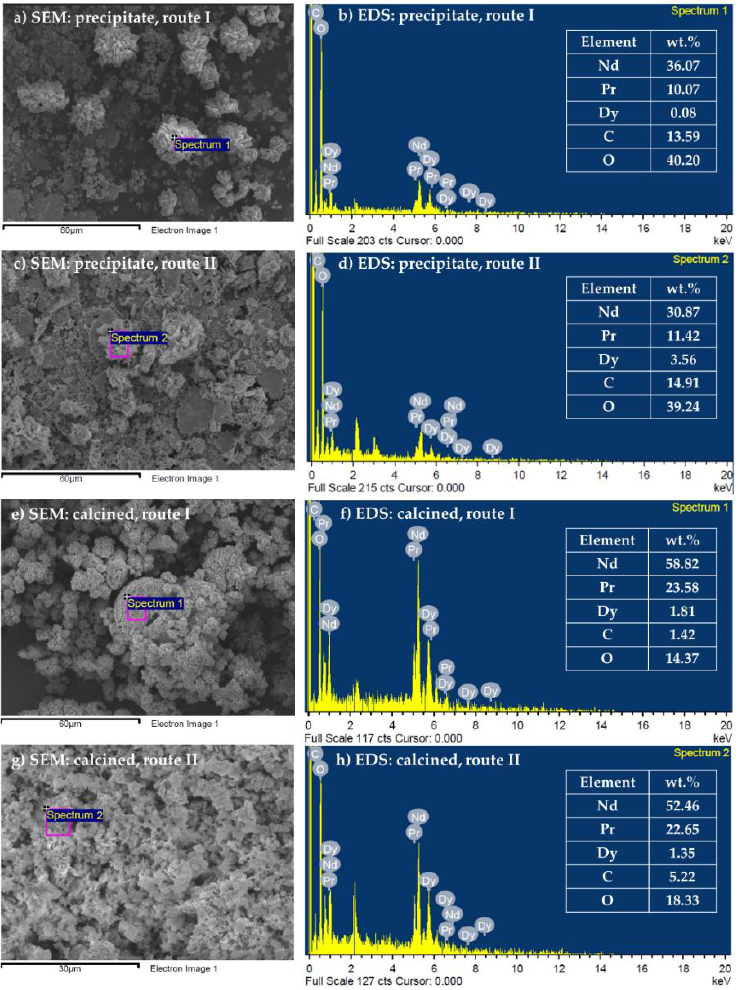
Figure 13. SEM and EDS analyses of ( a – d ) neodymium (RE) oxalates and ( e – h ) neodymium (RE) oxides obtained from route I: oxidative roasting and selective leaching, and route II: whole leaching.